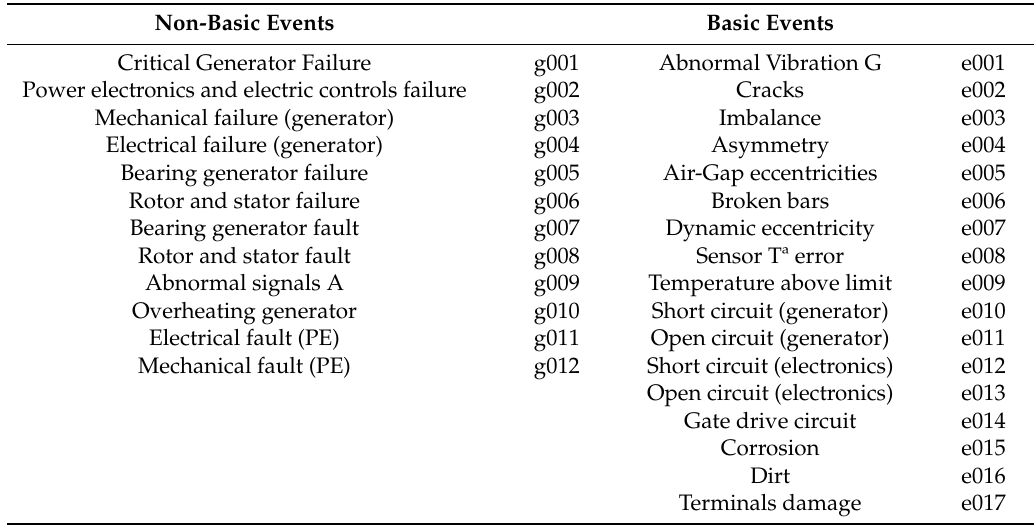
Table 2. Principal faults in the converter, generator, electrical and electronic components.